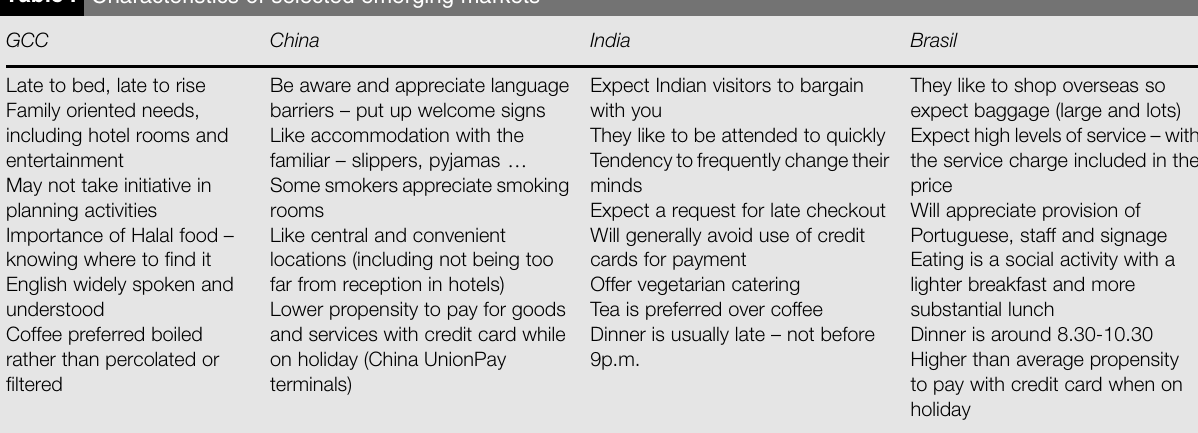
Table I Characteristics of selected emerging